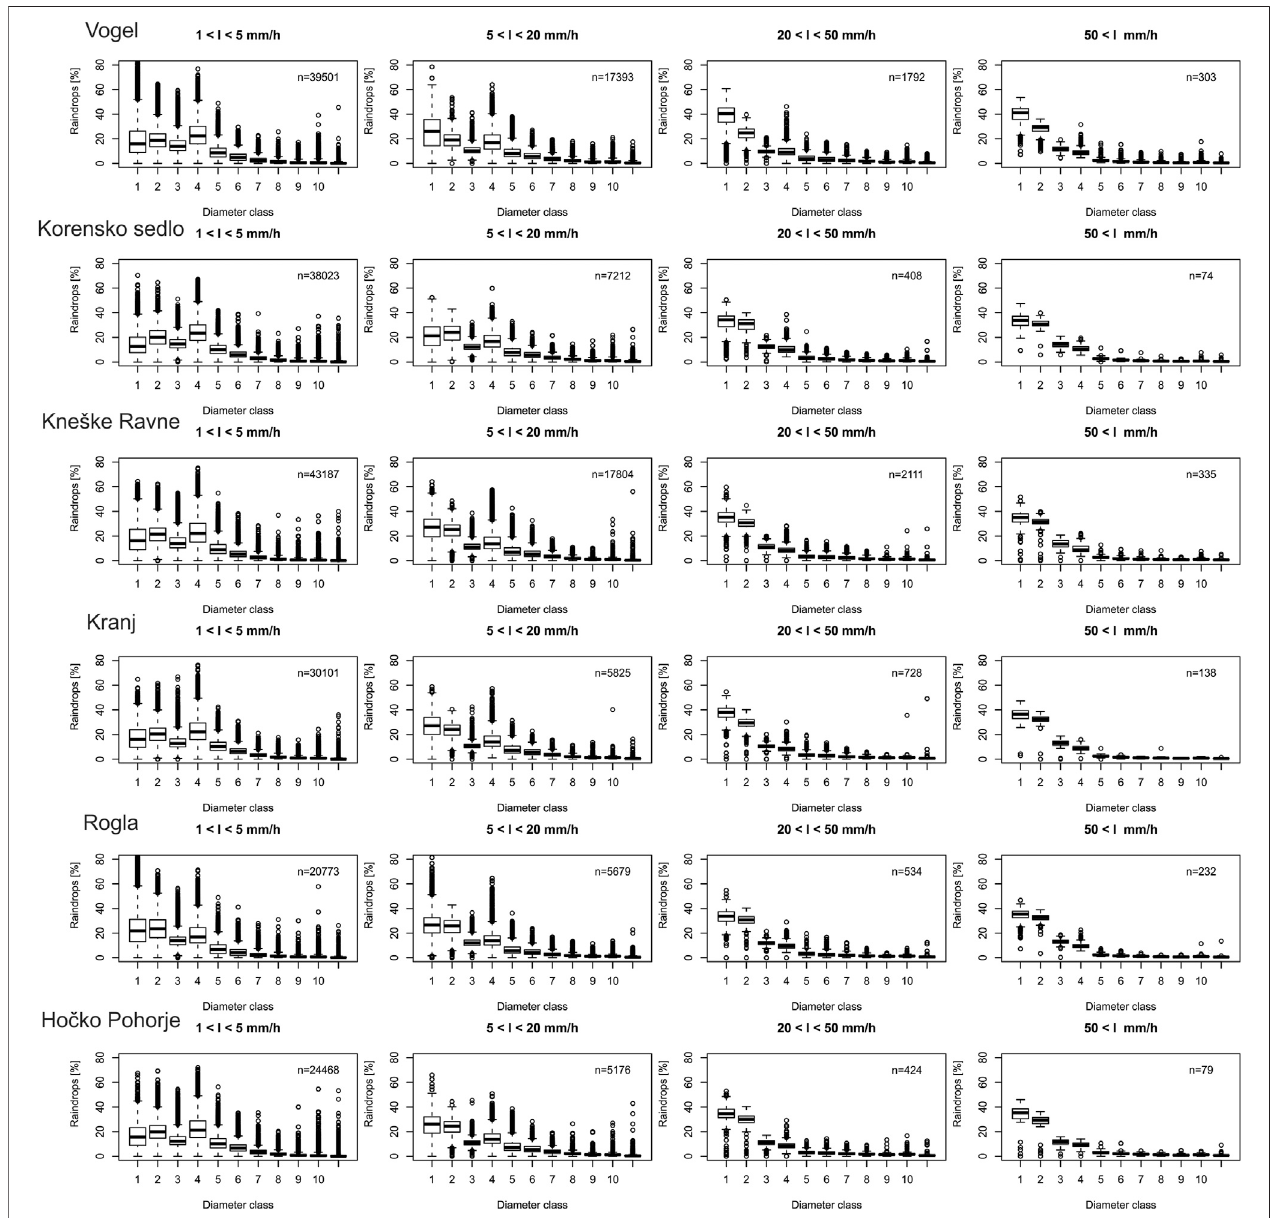
FIGURE 6 | Boxplots of the percentage of the DSD data in the fi rst 11 raindrop diameter classes for various rainfall intensities for analyzed stations. The mean diameter of drop size classes is shown in Optical Disdrometers section for the fi rst 11 classes.